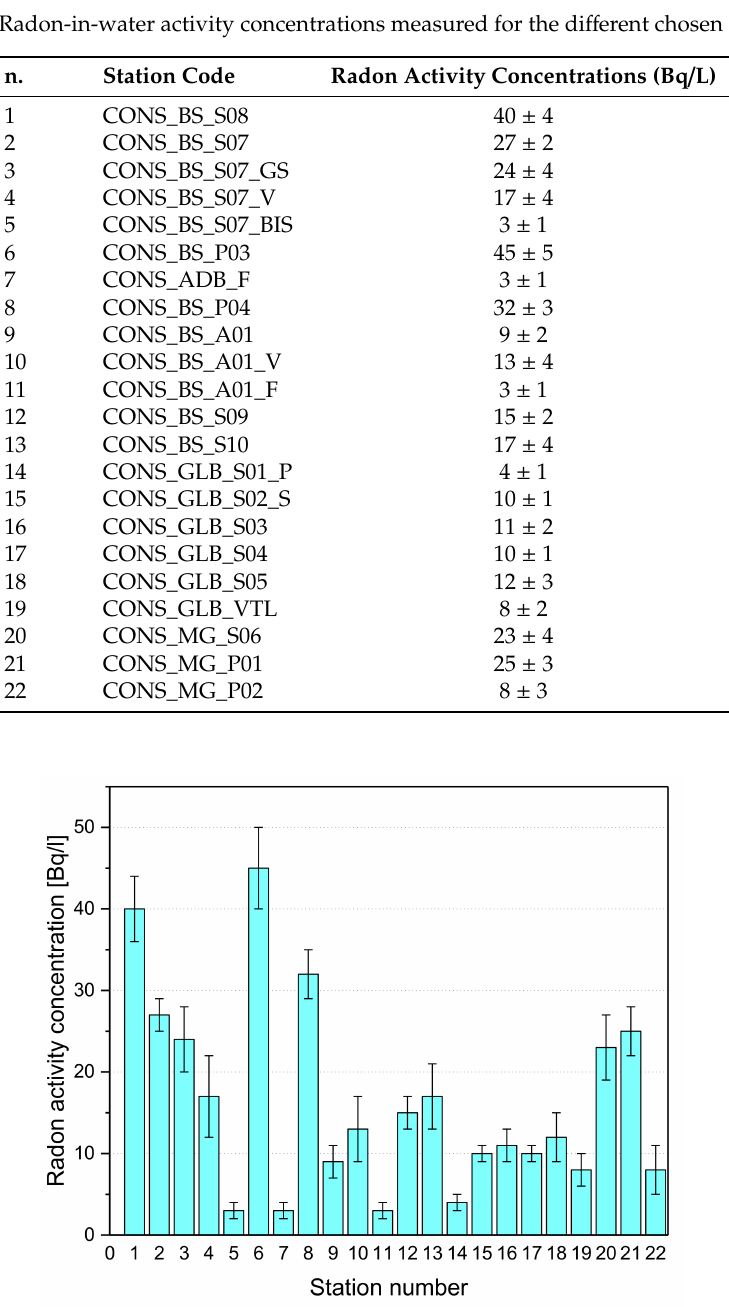
Figure 4. Radon-in-water activity concentrations measured in di ff erent typologies of groundwater springs in the province of Salerno, southern